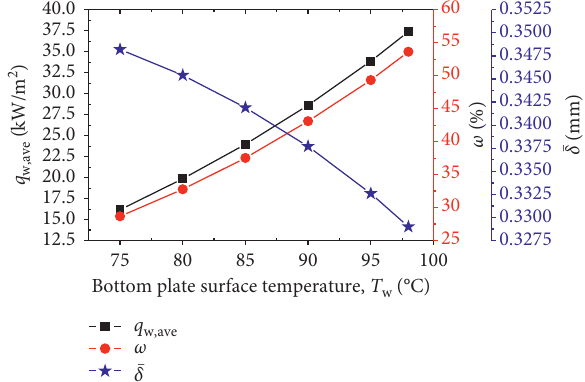
Figure 9: Influence of the bottom plate surface temperature on heat and mass transfer of the water film evaporation